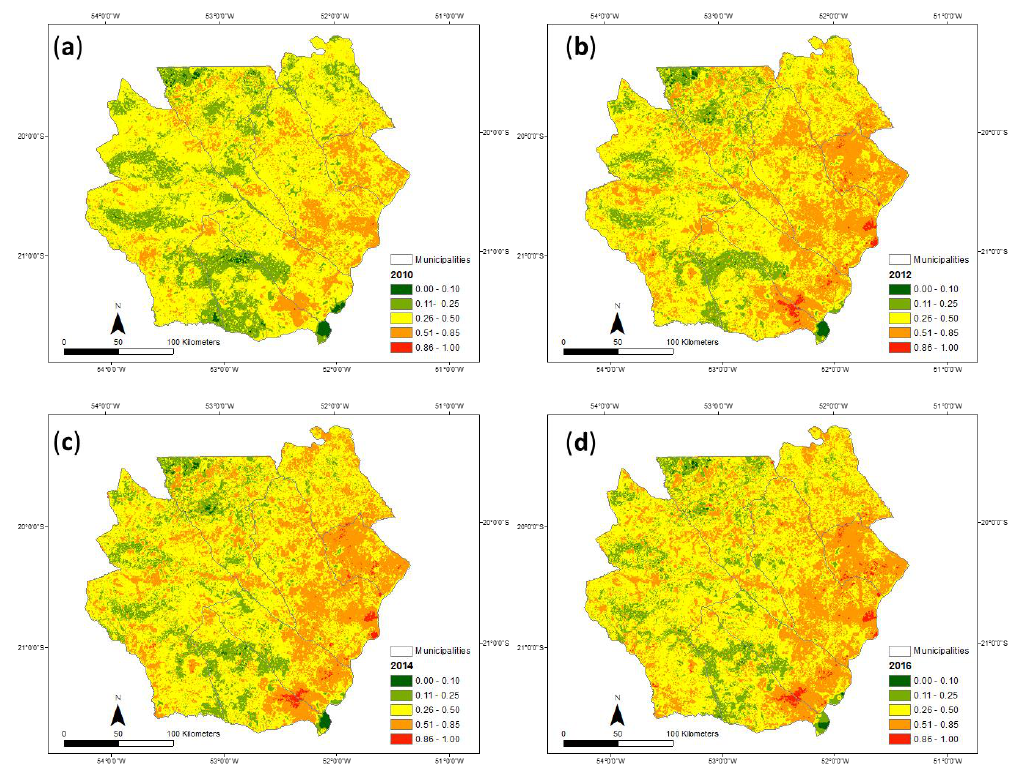
Figure 6. Predictions of fire ignition likelihood considering the land cover changes over the study period. ( a ) Predicted probability for 2010 (mean: 0.37). ( b ) Predicted probability for 2012 (mean: 0.43). ( c ) Predicted probability for 2014 (mean: 0.43). ( d ) Predicted probability for 2016 (mean: 0.44). Forests 2019 , 10 , x FOR PEER REVIEW Table 2. Predicted fire ignition probability classes over the studied period.